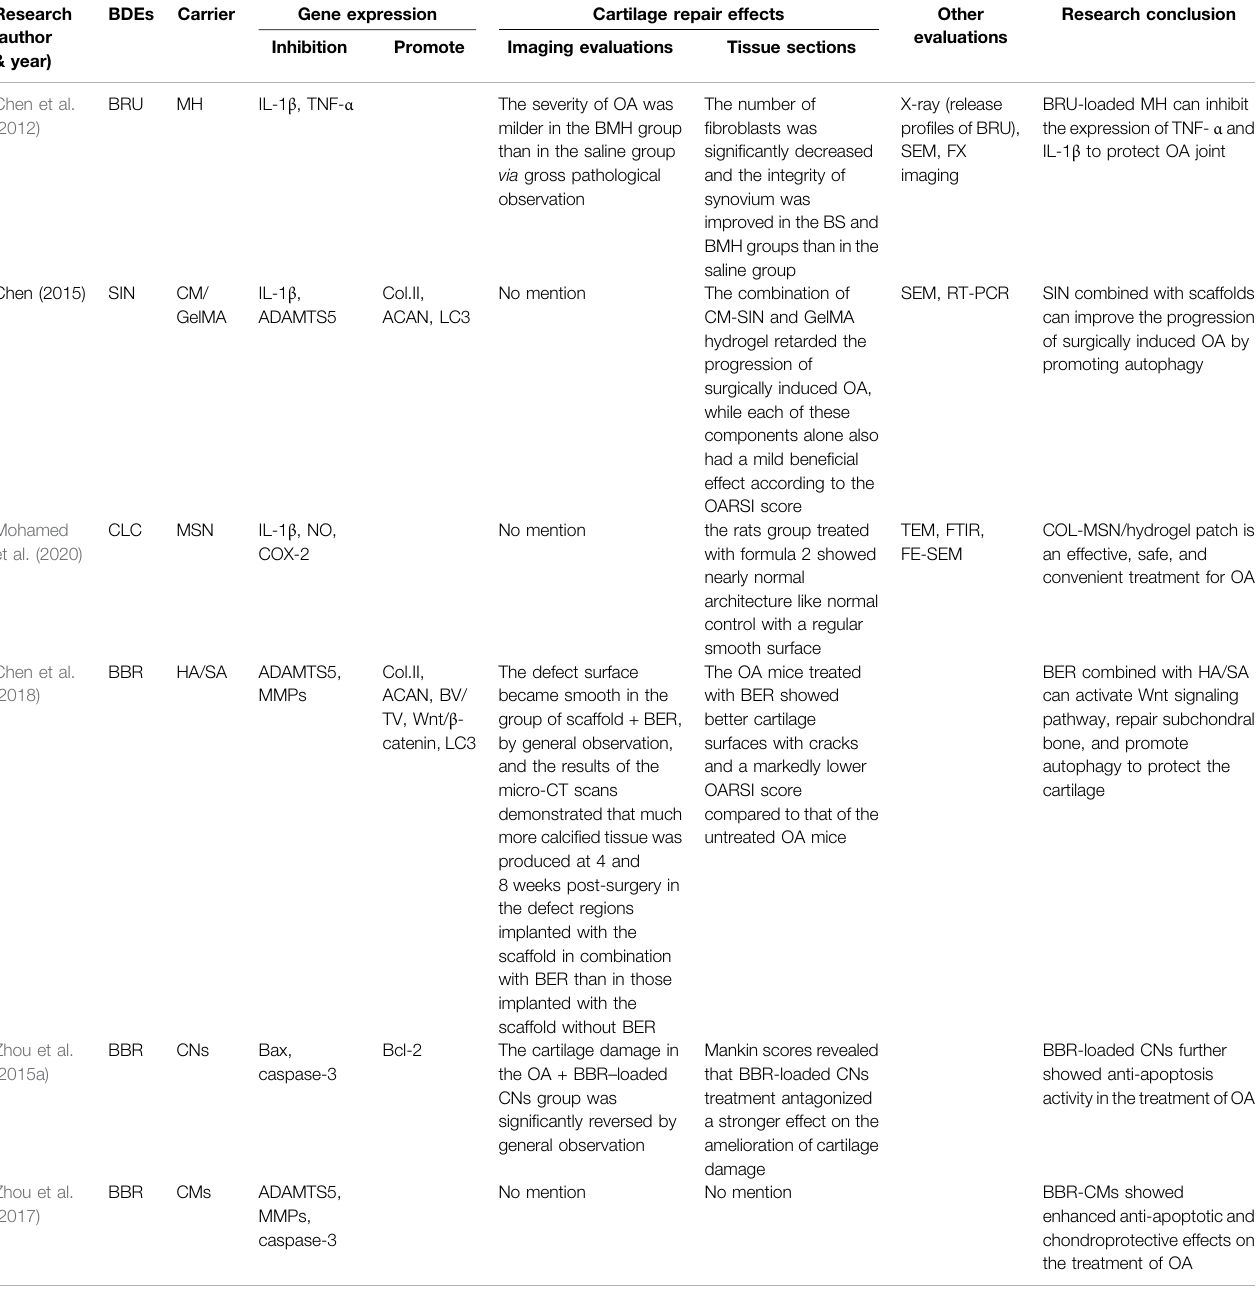
TABLE 4 | The effect of alkaloid active ingredients combined with carriers on OA cartilage